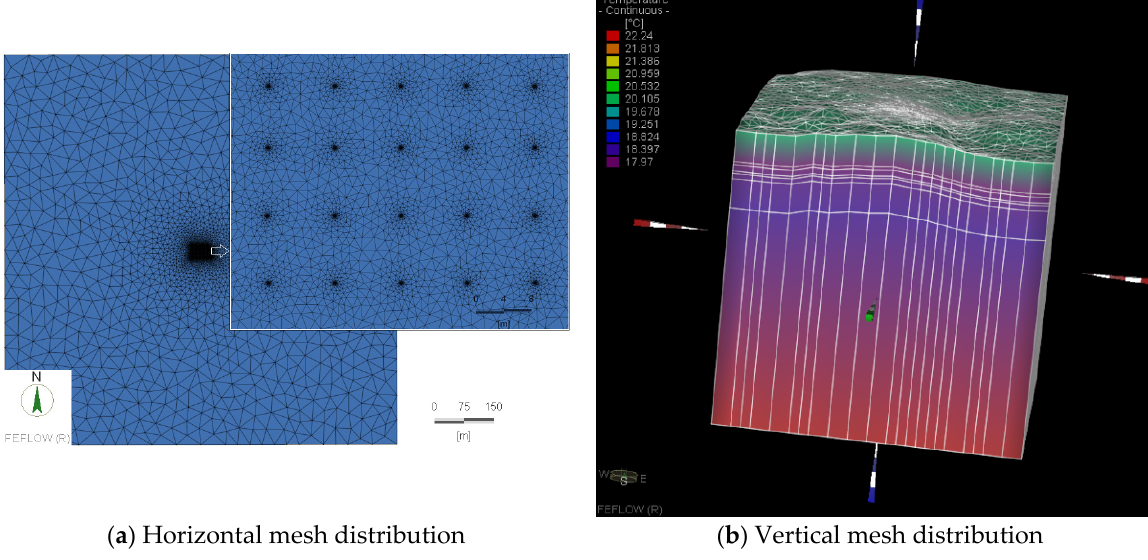
Figure 2. Mesh distribution of the study